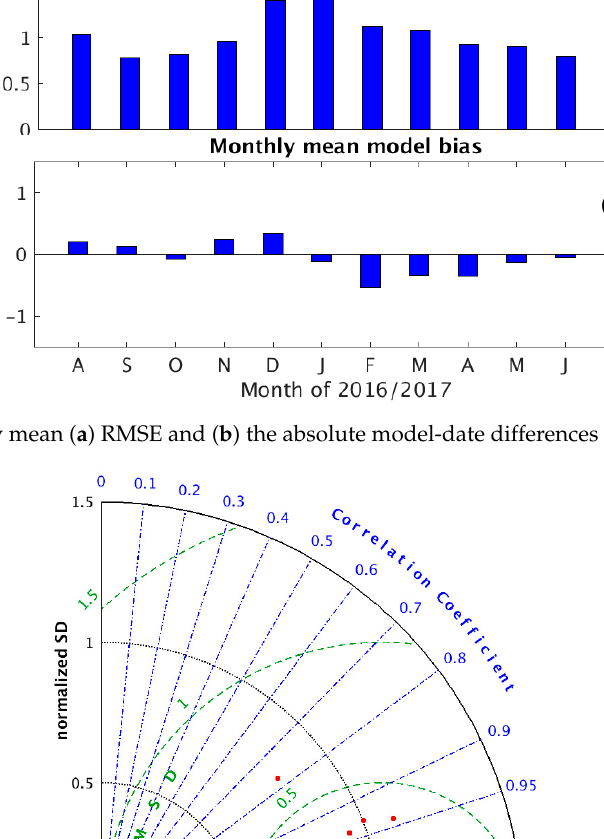
correlation coefficient, normalized SD (nSD) and normalized RMSE Figure 15. The Taylor Diagram of the sea-surface temperature. Shown on the plot are the model-data